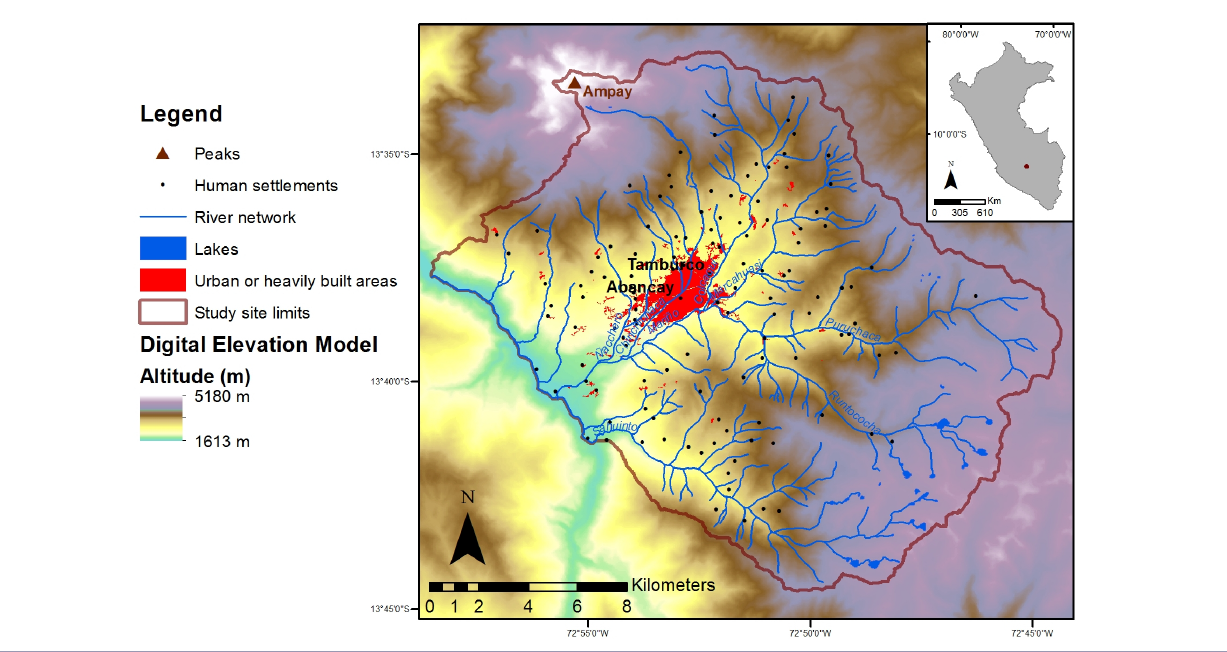
Fig. 2 . Map of the study site. Altitude ranges from 1613 m to 5180 m above sea level. The city of Abancay appears in red in the center of the map. The study site limits (brown line) correspond to the boundaries of the Mariño